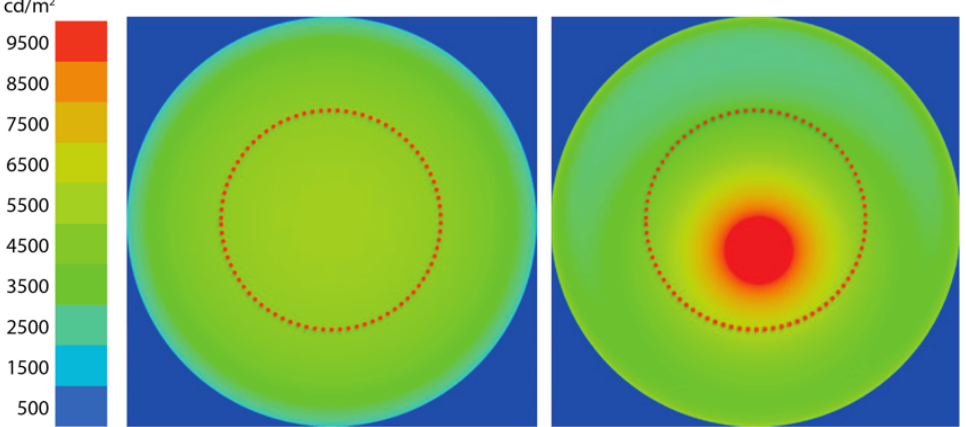
Figure 14. Shanghai Sky luminance distribution (China Standard Sky left, CIE Clear Sky right). Outer section of dashed circle denotes typical view from interior windows.